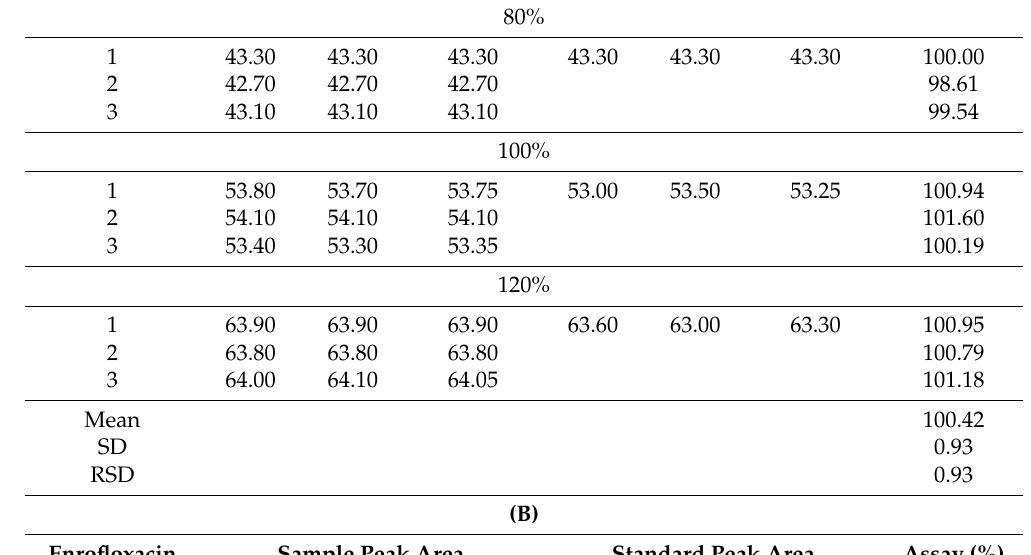
Table 3. Accuracy and precision results of amoxicillin (A) and enrofloxacin (B). (A) Amoxicillin Sample Peak